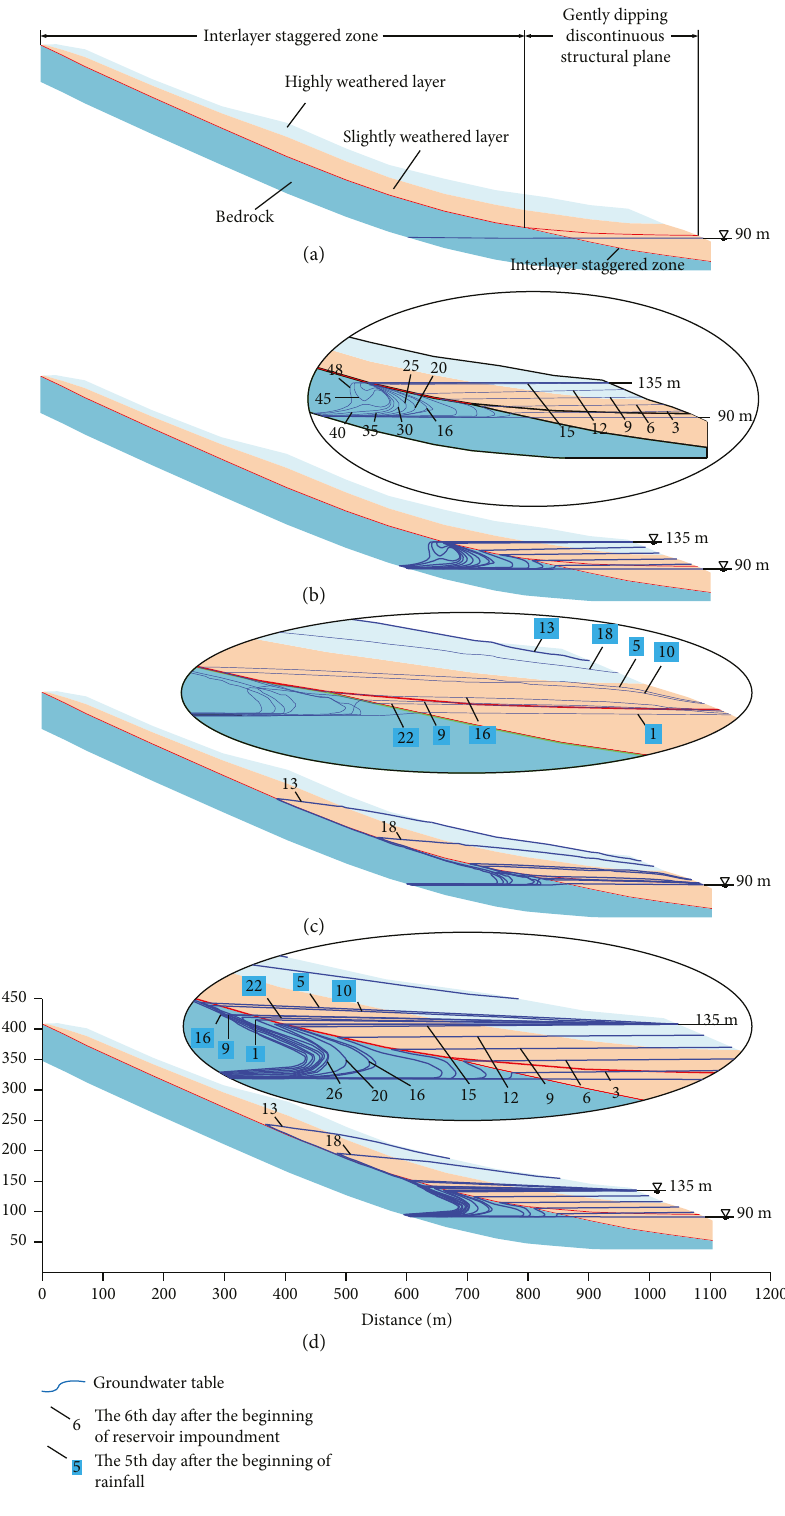
Figure 7: Groundwater tables in di ff erent